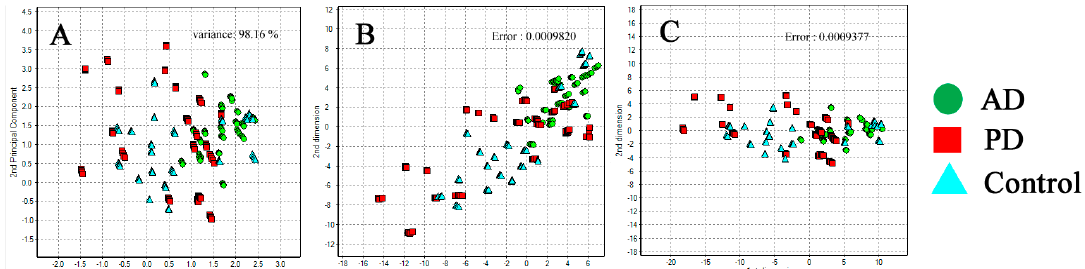
Figure 5. Distribution of clusters for exhaled breath samples from patients with Alzheimer’s disease (AD), Parkinson’s disease (PD), and from healthy individuals as a control group using system D. ( A ) Principle component analysis (PCA) pattern analysis of AD, PD, and control groups; ( B ) Sammon’s mapping of AD, PD, and control groups; ( C ) Combination of PCA and Sammon’s mapping for healthy individuals, AD patients, and PD patients.